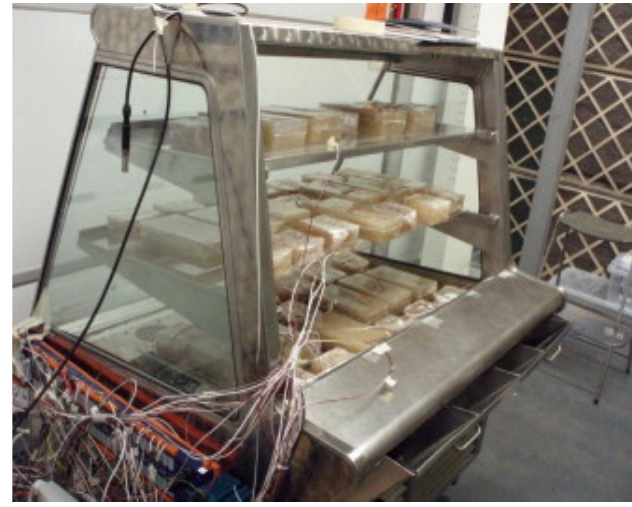
Figure 3 . Commercial display cabinet [61]. Figure 3. Commercial display cabinet [61].